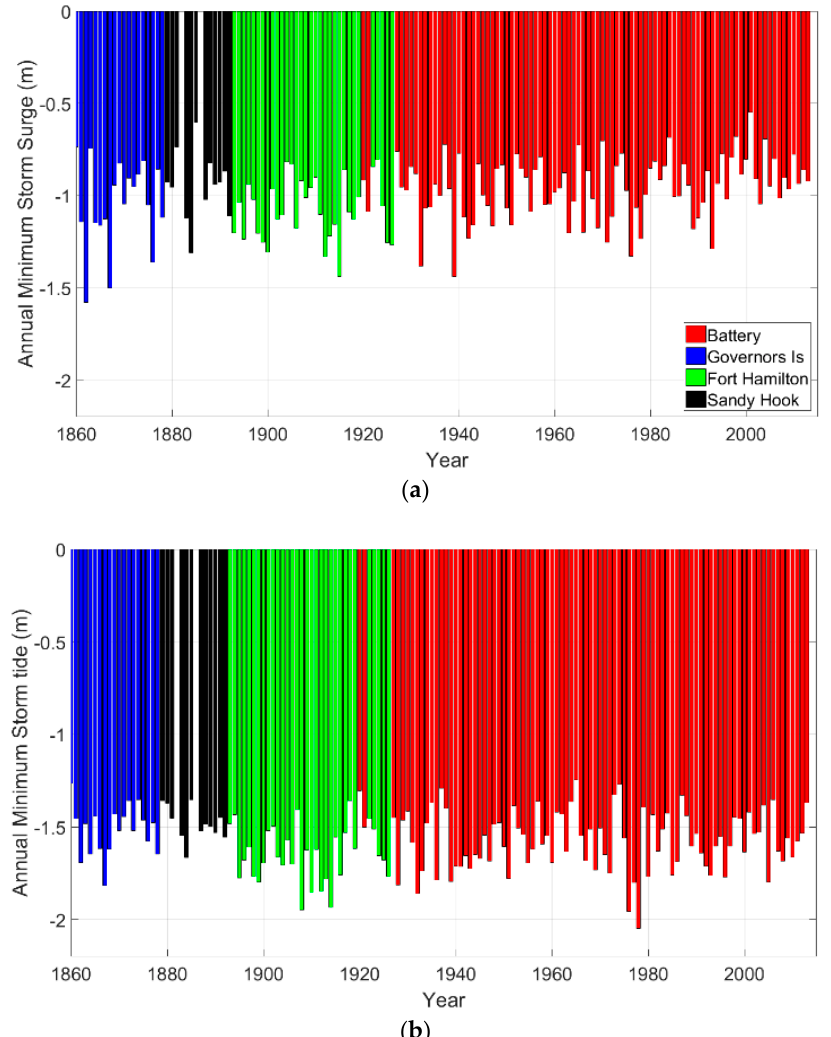
Figure 4. ( a ) Time series of annual minimum negative surges; ( b ) annual minimum storm tide (relative to local mean sea level) from 1860–2015 compiled from various tide gauge stations in NYH. The annual mean sea level has been subtracted to remove the effects of sea level-rise.